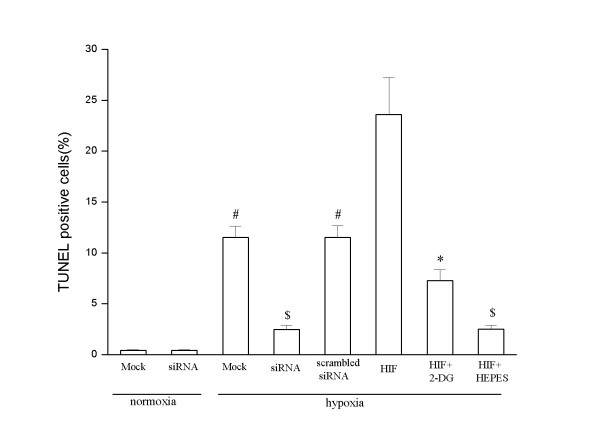
Detection of apoptosis by TUNEL: graphical format. TUNEL staining was performed on cells as described above. Shown is a graphical representation of the staining shown in Fig. 9. $, P < 0.05 compared to normoxic mock transfected and HIF-1α siRNA; *, P < 0.05 compared to hypoxic HIF-1α siRNA and HIF-1α expression vector with HEPES; #, P < 0.05 compared to hypoxic HIF-1α expression vector with or without 2-DG. siRNA: A549 cells transfected HIF-1α siRNA vector, Mock: mock-transfected, HIF: A549 cells transfected with HIF-1α expression plasmid, HIF+2-DG: Cells transfected with HIF-1α expression plasmid and cultured with 2-DG, HIF+HEPES: Cells transfected with HIF-1α expression plasmid and cultured with medium containing HEPES.